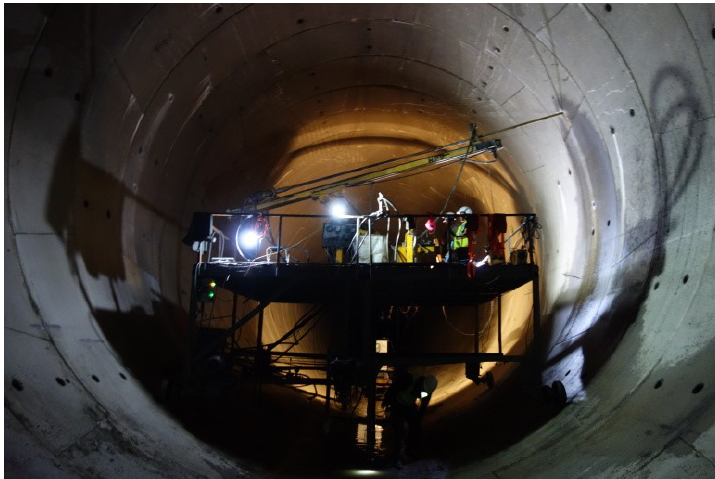
Figure 6. Core drilling in the TBM